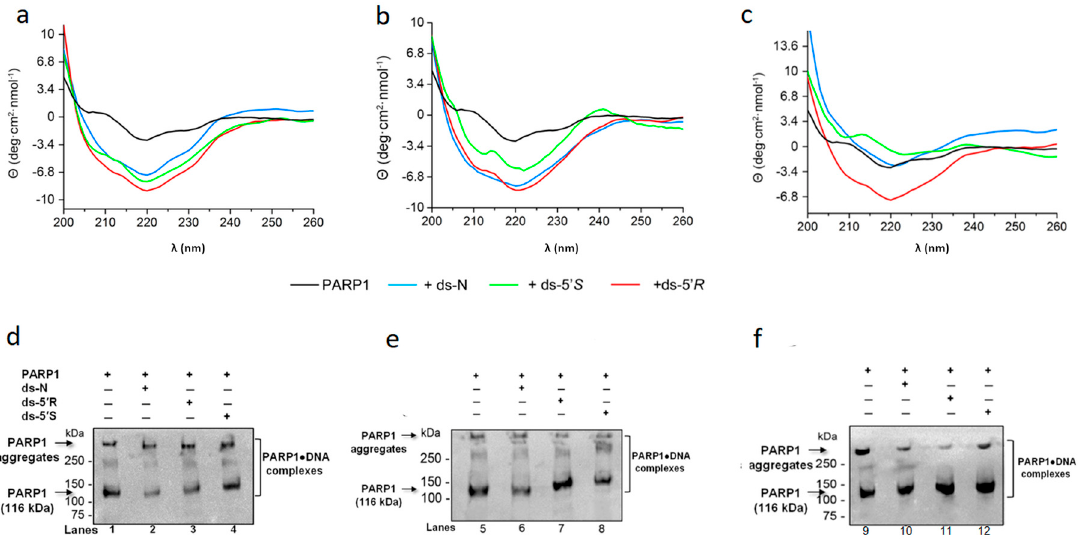
Figure 3. Circular dichroism and immunoblotting analysis for determining PARP1 binding to ds-oligonucleotides with cdA lesions. ( a – c ) CD profiles of PARP1 without or with the substrates. Human PARP1 protein only (15 µ g · mL − 1 , black line), PARP1 along with 50 nM ( a ), 100 nM ( b ), or 200 nM ( c ) ds-N (blue line), or ds-5’ S (green line) or ds-5’ R (red line), respectively. ( d – f ) Immunoblotting results of PARP1 in the presence of 50 nM ( d ), 100 nM ( e ), and 200 nM ( f ) oligonucleotide substrate. Lanes 1, 5, and 9 correspond to PARP1 only. Lanes 2, 6, and 10 correspond to PARP1 with 50 nM, 100 nM, and 200 nM ds-N, respectively. Lanes 3, 7, and 11 correspond to PARP1 with 50 nM, 100 nM, and 200 nM substrates containing a ds-5’ R -cdA, respectively. Lanes 4, 8, and 12 correspond to PARP1 with 50 nM, 100 nM, and 200 nM substrates containing a ds-5’ S -cdA, respectively. The results in the panels d-f are from different immune blottings; the blots are shown in Figure S5.